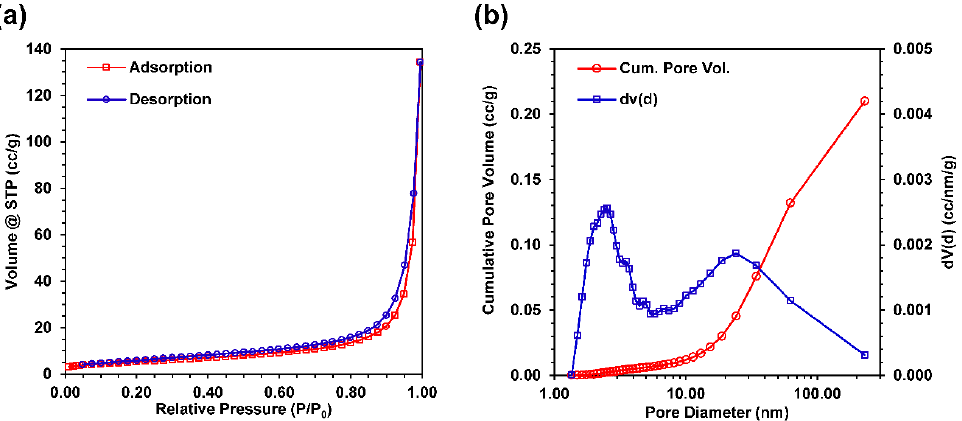
Figure 6. Gas adsorption data for Au-Cu nanofoam sample. ( a ) Complete nitrogen adsorption–desorption isotherms; ( b ) Pore size distribution with cumulative pore volume calculated by BJH